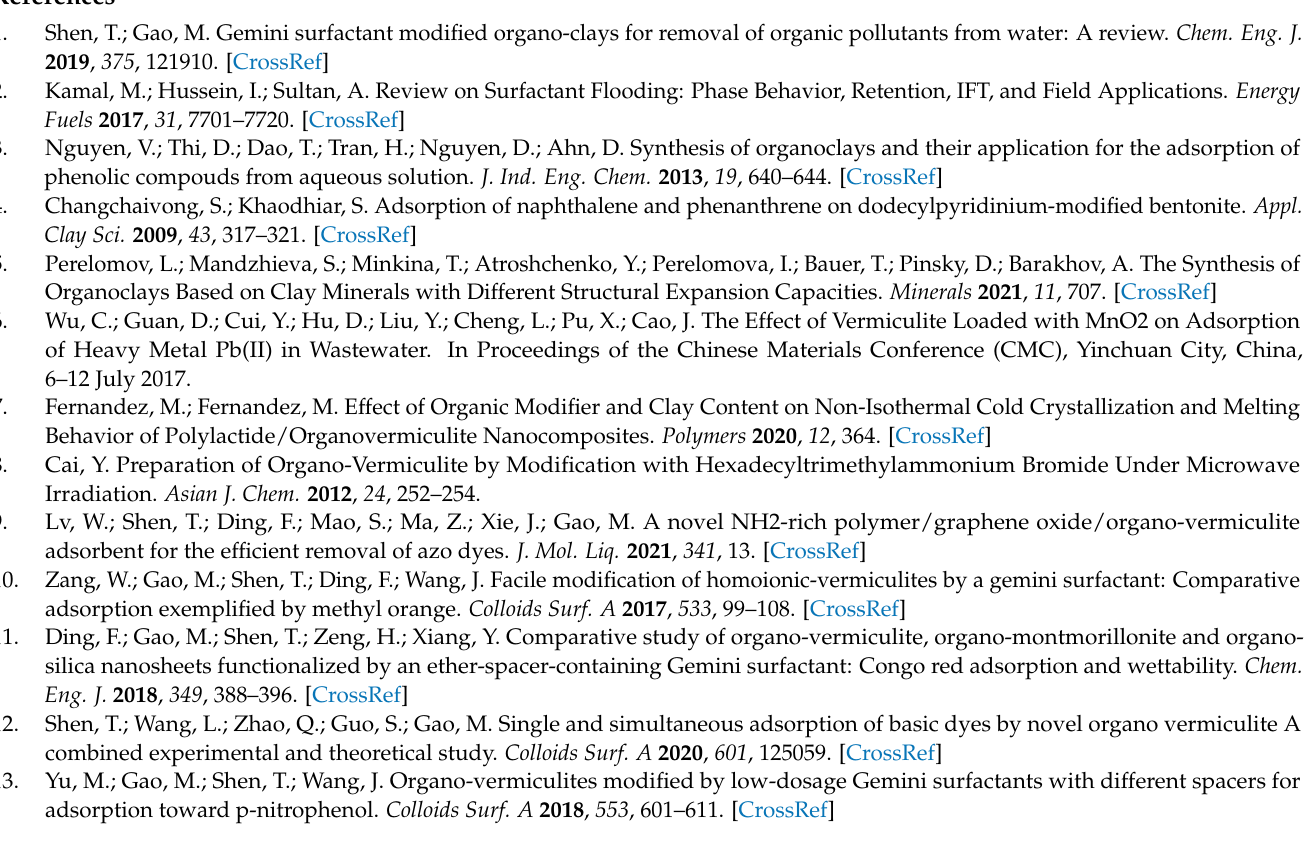
Figure S3: The SEM image of Na-Vt; Table S2 Zeta potential values of 5N-Vt, 7N-Vt and